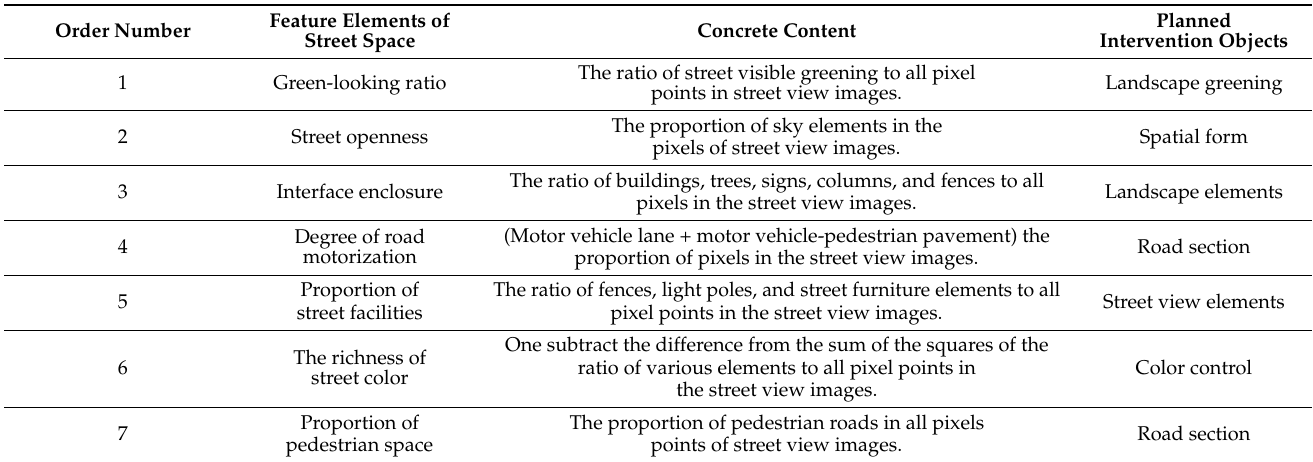
Table 1. Extraction of street spatial feature